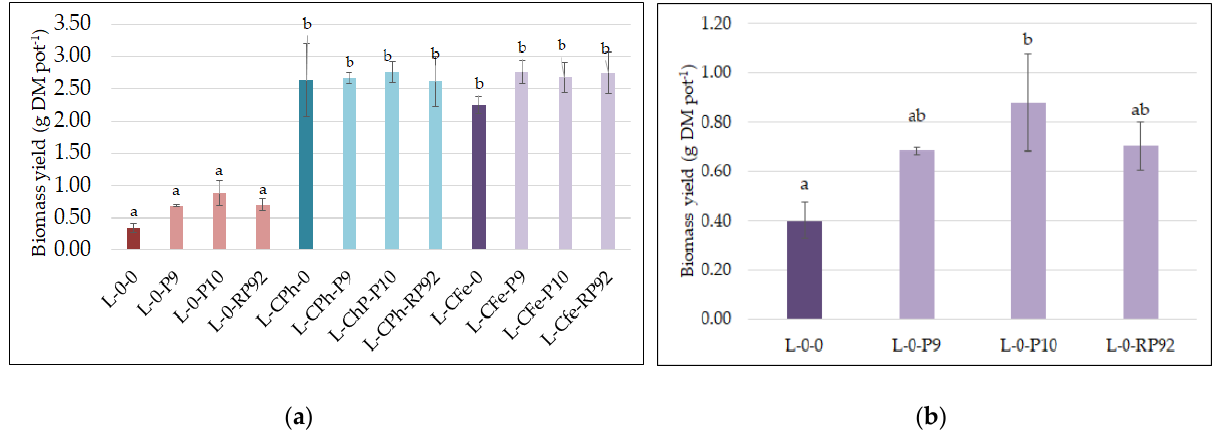
Figure 1. The effect of soil amendment and inoculation on grass biomass at harvest: ( a ) all treatments presented and statistically evaluated; ( b ) the effect presented and statistically evaluated separately for L-0 combinations (inoculation effect without soil amendments).